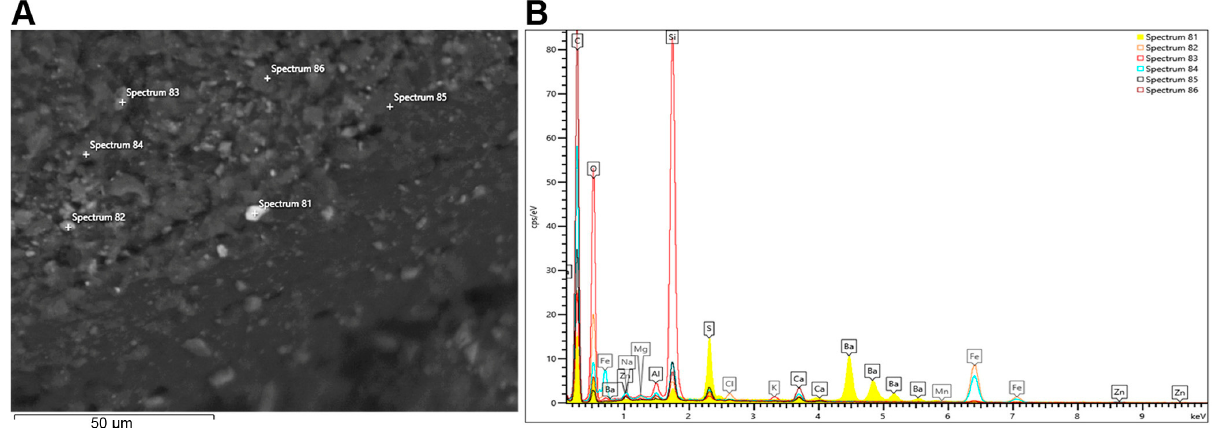
Figure 5. Scanning electron microscopy (SEM). Analysis of passenger particles ( A ) and the related spectrum of the microanalysis with EDS ( B ).